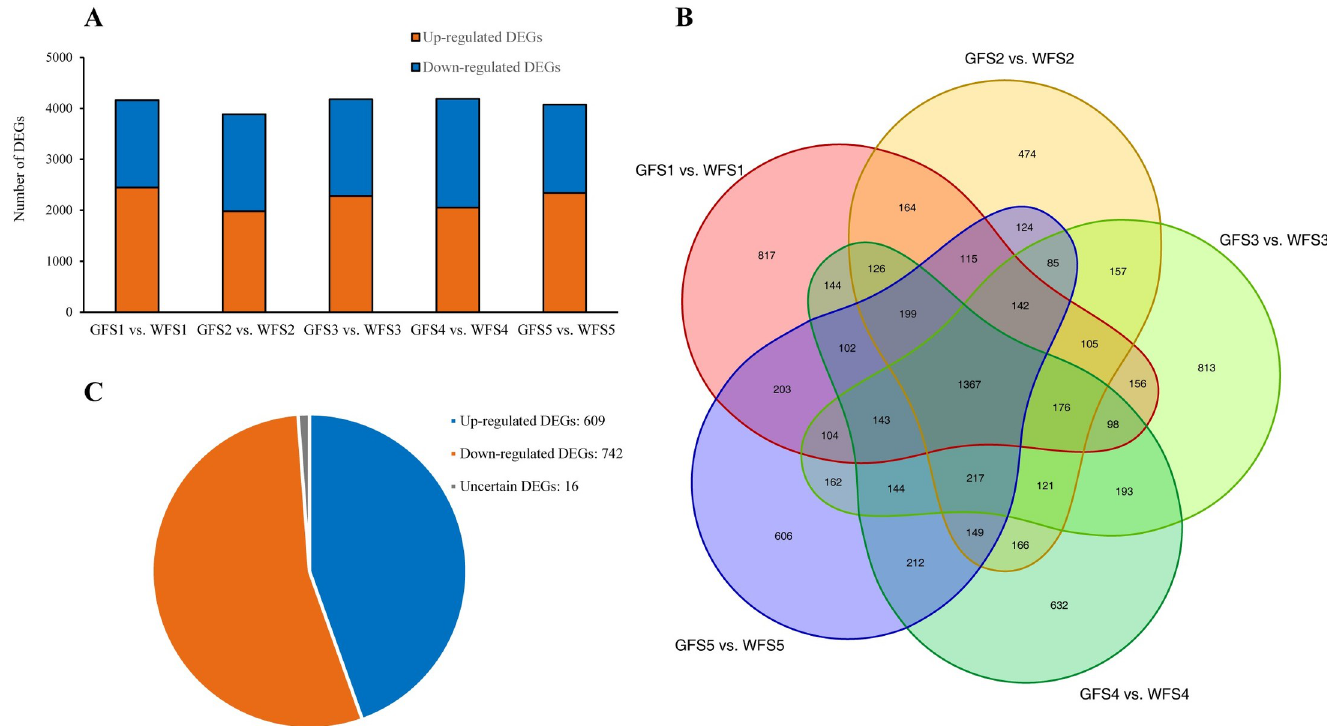
Fig 5. Distribution of DEGs obtained from the taproot flesh transcriptomes of GF and WF. A , DEGs between the GF and WF at five corresponding stages; B , Venn diagram showing the overlap in DEGs between GF and WF at the five developmental stages. The number in the cycle indicating the number of DEGs; C , Distribution of 1367 DEGs, which were consistently differentially expressed across the five